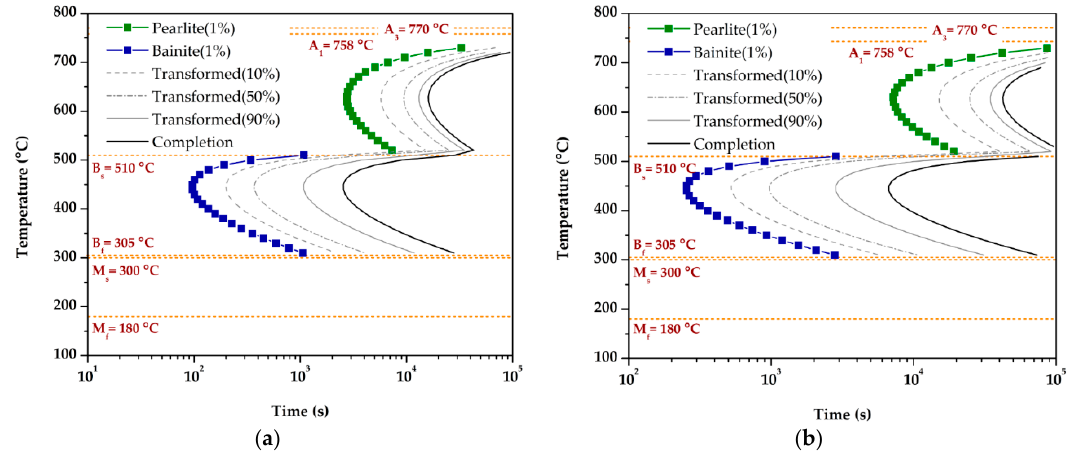
Figure 2. Influence of grain size on the bainitic transformation nose on the TTT diagram: ( a ) 130 μ m; ( b ) 350 μ m.